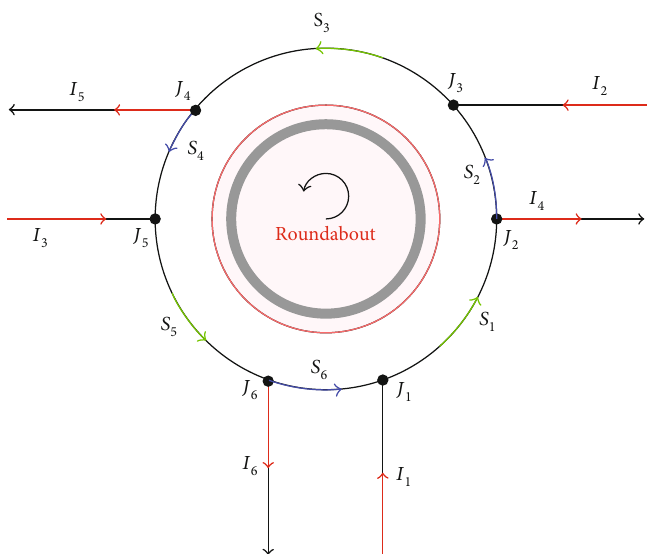
Figure 1: Schematic diagram representing a roundabout with 3 entering and 3 exiting roads.